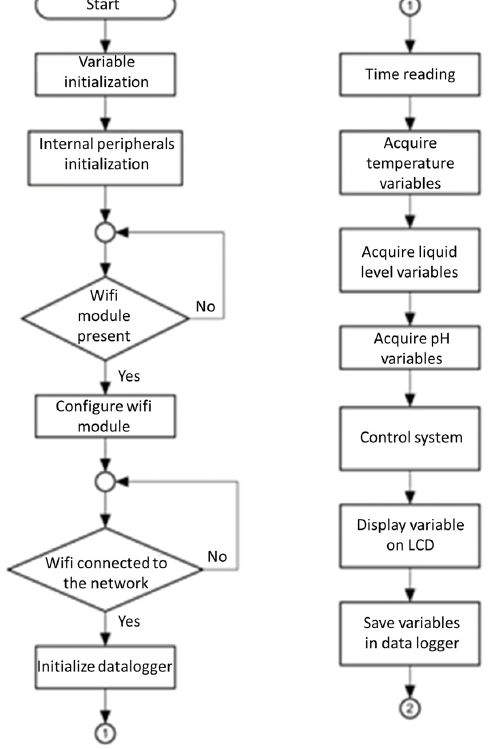
Figure 3. Instrumentation System Flow Chart—Part 1.